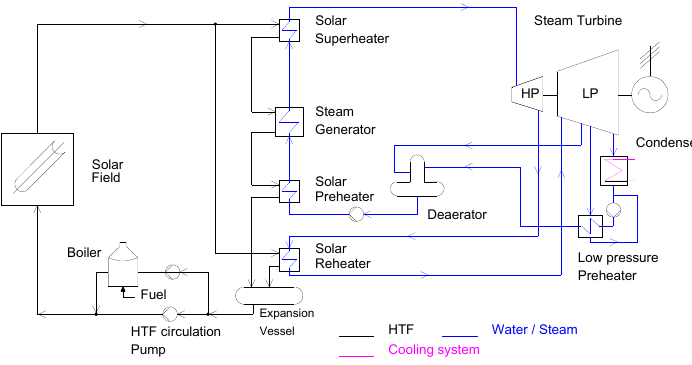
Figure 2. Solar-only PT and oil–steam thermal exchange. Heat transfer fluid (HTF); high pressure (FP); low pressure (LP).